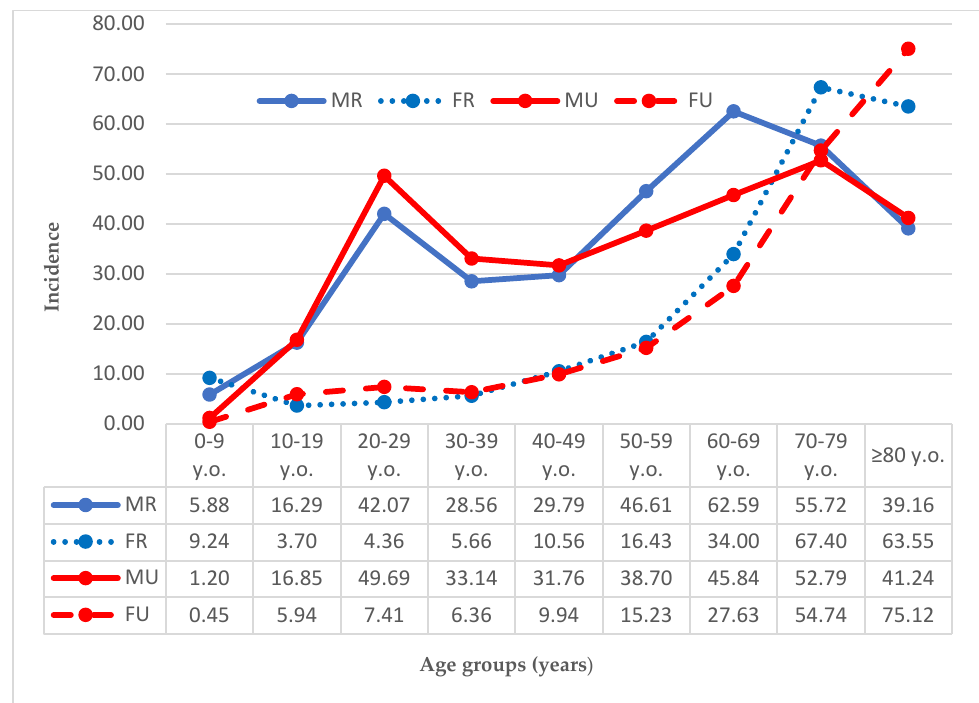
Figure 5. Incidence rate (nr. of cases/100,000 person-years) of dislocations by age and sex. Legend: MR, male rural population male; FR, female rural population; MU, male urban population; FU, female urban population.